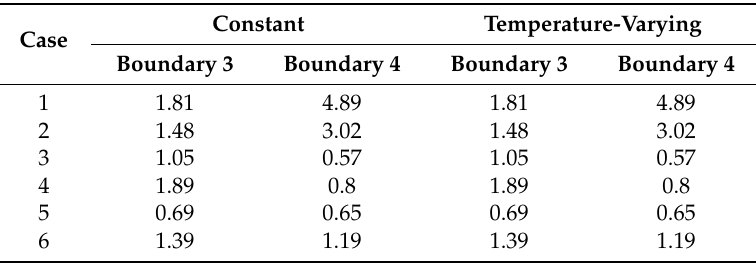
Table 8. Calculation errors of transient conductor-temperature using constant and temperature-varying thermal capacitances ( ◦